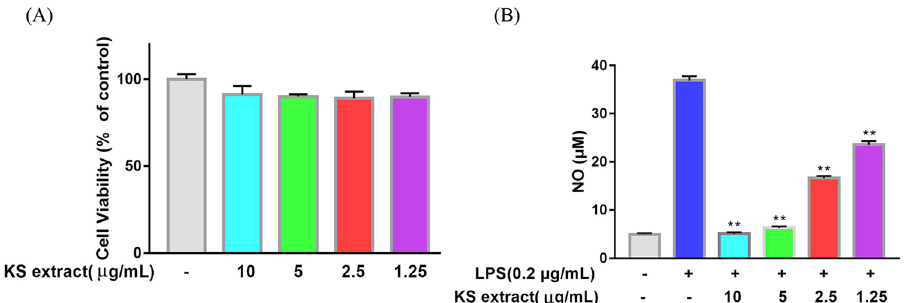
Figure 5. Effect of Kushen extract on RAW264.7 cells. ( A ) Cell viability of RAW264.7 cells after being treated by Kushen extract was detected by the CellTiter-LumiTM Plus, ( B ) NO production of LPS stimulated RAW264.7 cells after being treated with Kushen extract was detected by the Griess reaction. Data were presented as the mean ± SEM (n = 6), *p < 0.05 and **p < 0.01 versus LPS-treated group was considered statistically significant differences.